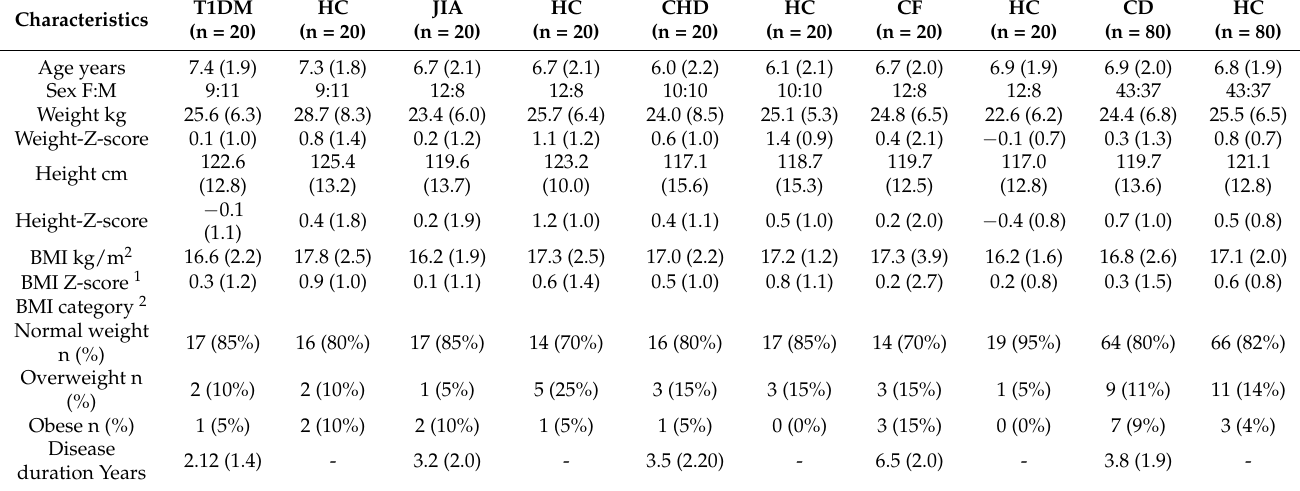
Table 1. Characteristics of children with chronic disease and healthy controls age- and sex-matched groups. Data are presented as mean